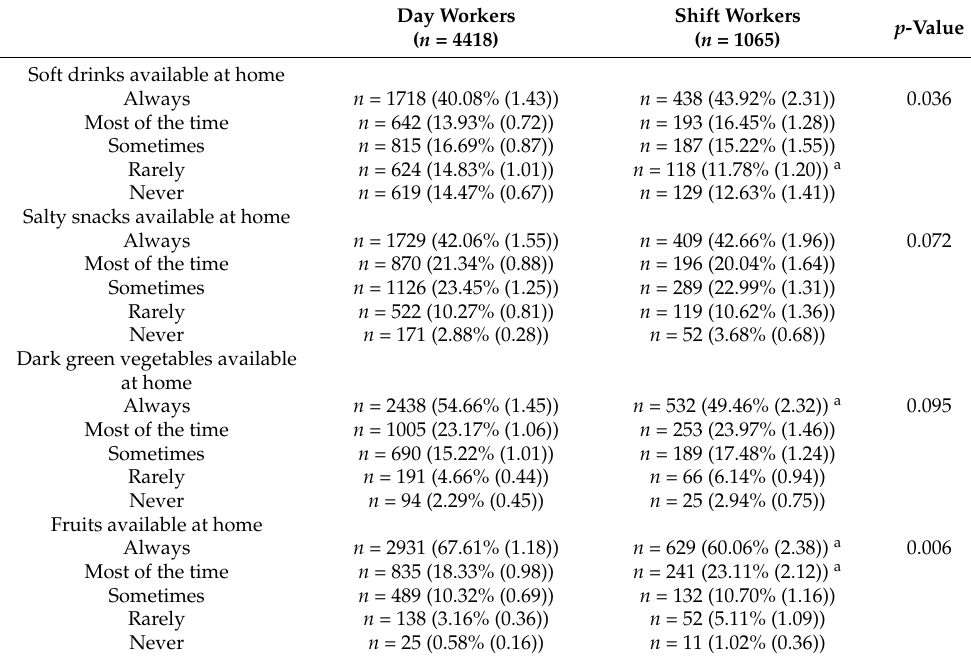
Table 2. Food availability at home: a comparison by shiftwork